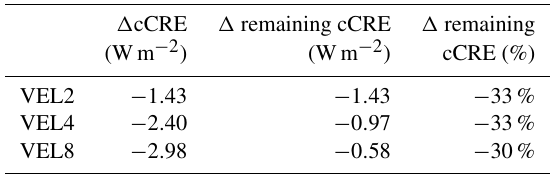
Table 2. Cirrus geoengineering CRE anomalies in Wm − 2 with re- spect to REF (first column) or with respect to the simulation with 2 times smaller IC sedimentation velocities (second column) for fixed SST simulations. The last column represents the relative fraction of the cirrus cloud radiative effect (cCRE) anomaly with respect to the remaining cCRE.